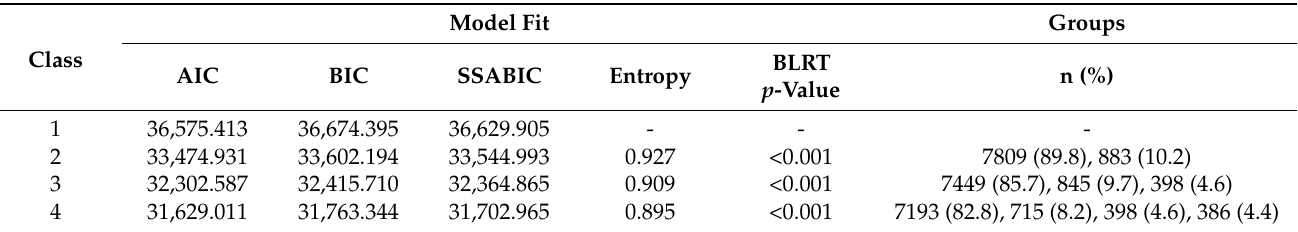
Table 4. Model fit of Growth Mixture Modeling. ( N = 8692).